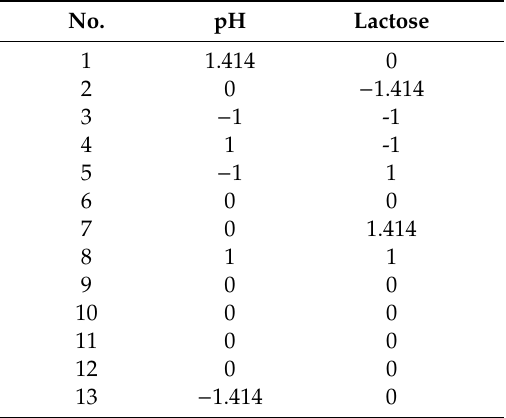
Table 4. The experimental runs for the central composite design for five levels of independent factors.